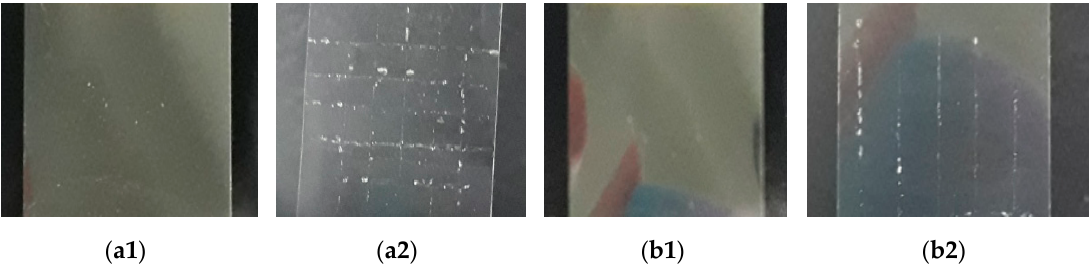
Figure 6. Adhesion characteristics of the functional coating according to the annealing gas, ( a1 ) is tape before the hardness test of the naturally dried film, ( a2 ) is tape after the hardness test of the naturally dried film, ( b1 ) is tape before the hardness test of the annealed film, ( b2 ) is tape after the hardness test of the annealed film.